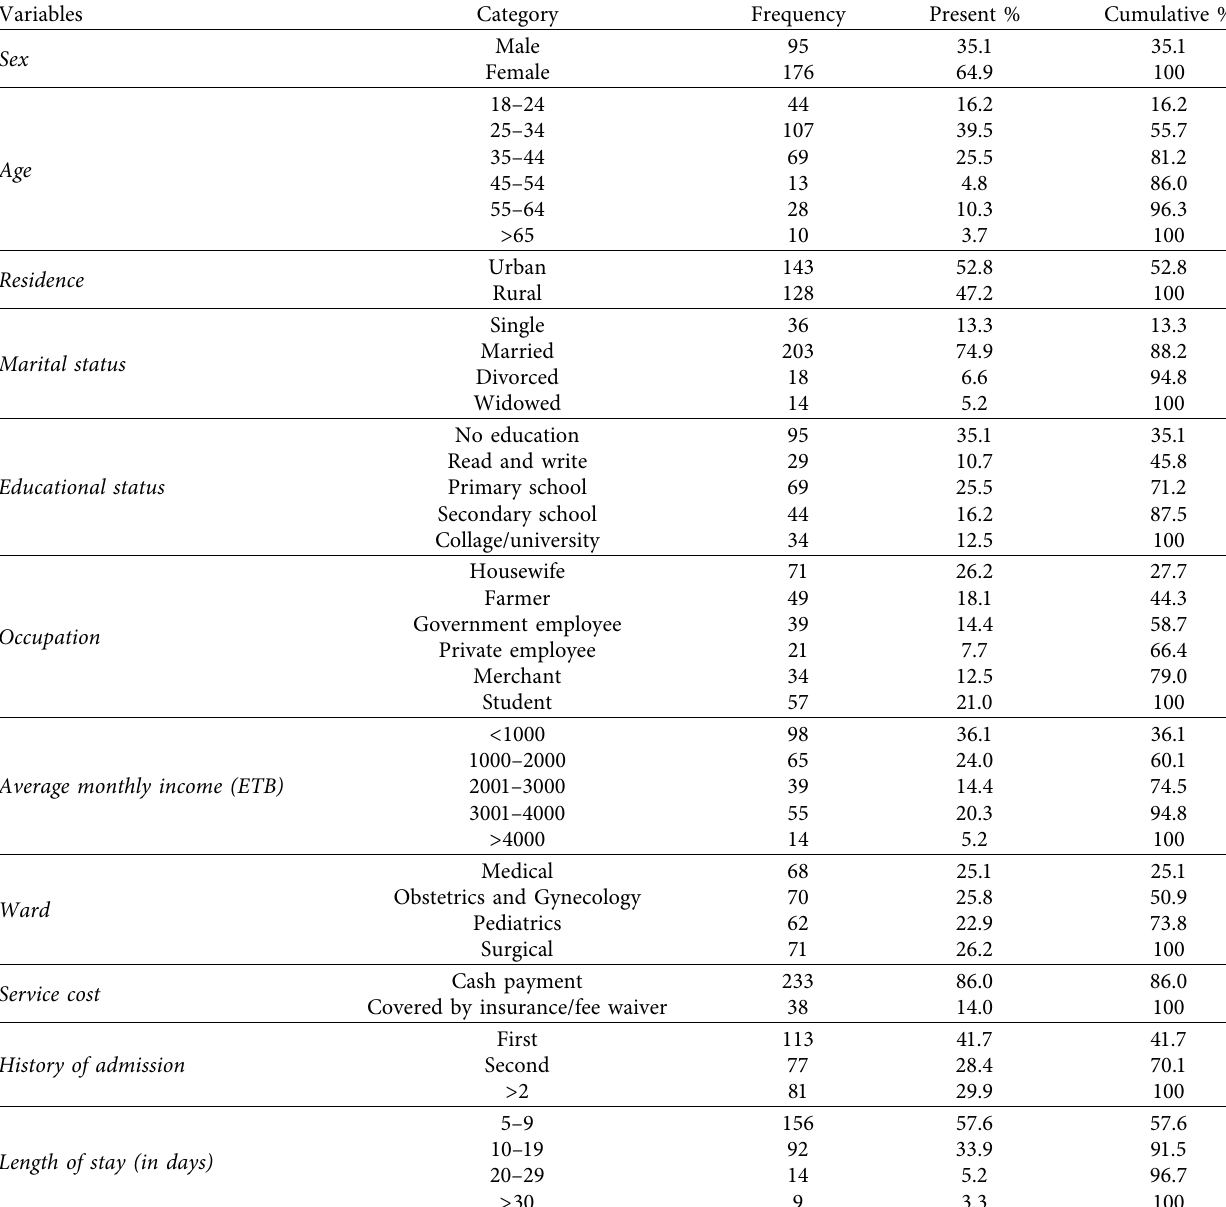
Table 1: Demographic and socioeconomic characteristics of patients ( n � 271) for assessment of patient satisfaction toward quality of care in the wards of Gambella Hospital, southwest Ethiopia,